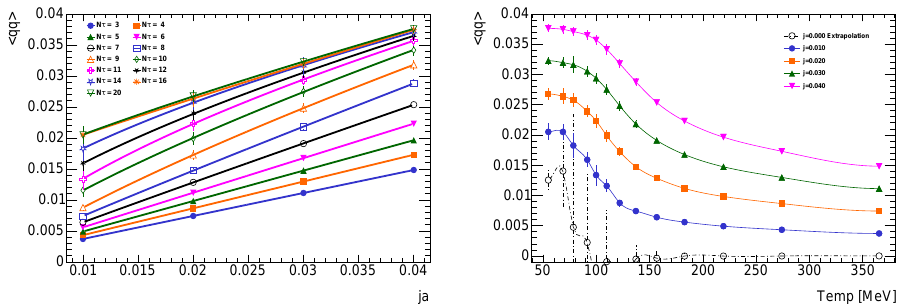
Figure 2: Unrenormalised diquark condensate (cid:104) qq (cid:105) as a function of diquark source j and temperature T . We extrapolated j to zero in figure 2a to obtain the hollow points in figure 2b.